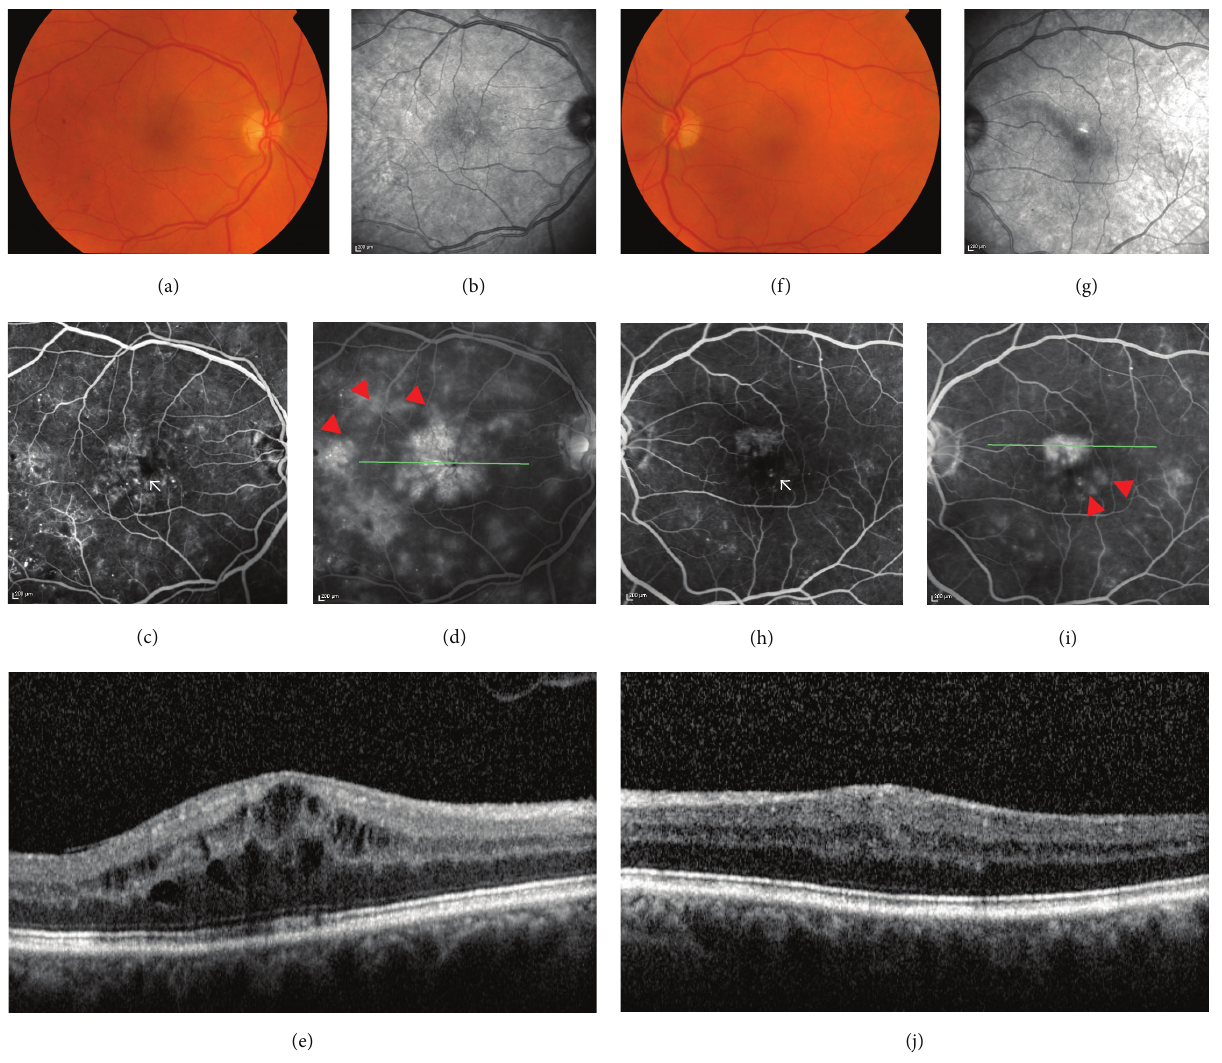
Figure 1: A composite of colour, infrared photographs, early and late fluorescein angiogram frames, and spectral domain optical coherence tomography (OCT) scan of the right eye (left column (a)–(e)) and left eye (right column (f)–(j)). Note the irregularities of the foveal avascular zone (white arrow) and the areas of vascular leakage at the macula (red arrowheads). The green line indicates the position of the OCT